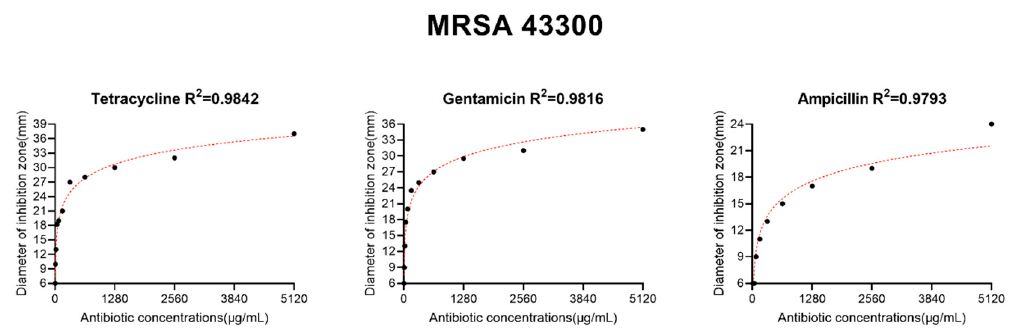
Figure A2. The optimum concentration of antibiotics against MRSA 43300 (partial).